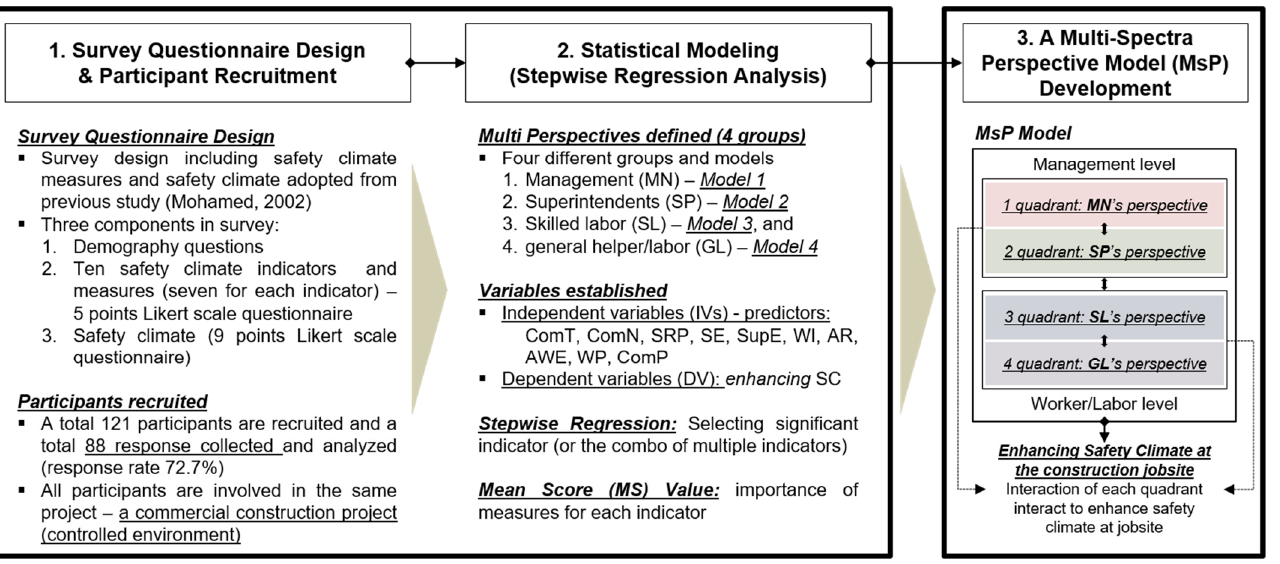
Figure 1. Overall research method.